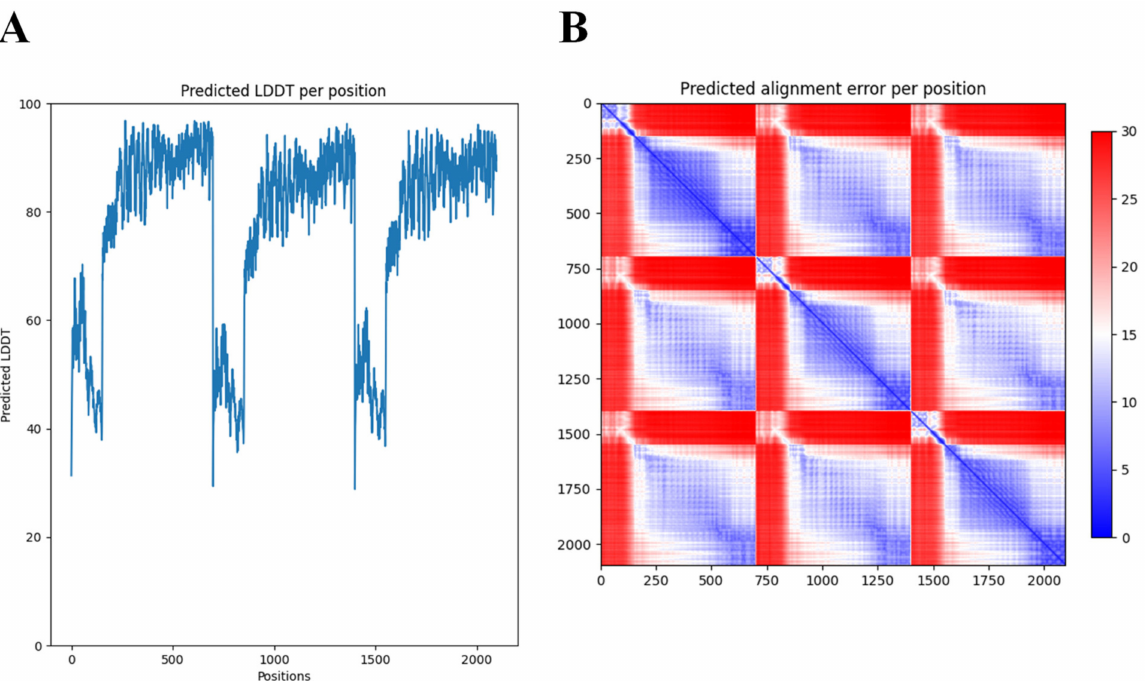
Figure 4. Predicted Local Distance Difference Test (LDDT) and alignment error per position of the 3D structure of DpoMK34 generated by AlphaFold-Multimer. ( A ) The predicted LDDT scores of the predicted trimeric structure by AlphaFold. These scores are a per-residue measure of how confident AlphaFold is about its prediction. Note that the position axis refers to the concatenation of the three monomers. ( B ) The predicted alignment error, which can be used to interpret the relative position of domains. A low predicted alignment error (blue) between the residues of different domains indicates that AlphaFold predicts the relative positions of these domains well. When the predicted alignment error between domains is high (red), the relative position of these domains is